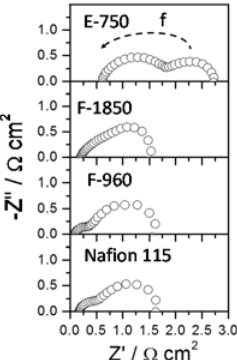
Figure 6. Ac-impedance plots for selected MEAs equipped with different membranes at 60 °C (2 M MeOH, 75 mA·cm − 2